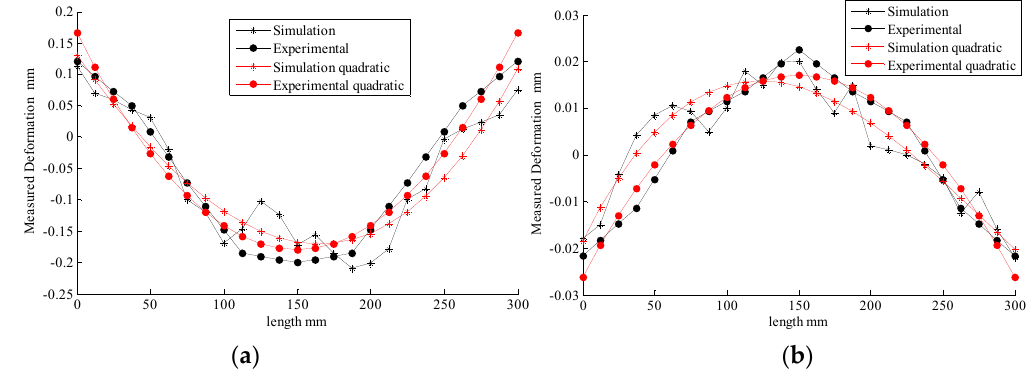
Figure 10. Measured deformation results of experiment and simulation for cross-section D. ( a ) Specimen 1; and ( b ) Specimen 2.